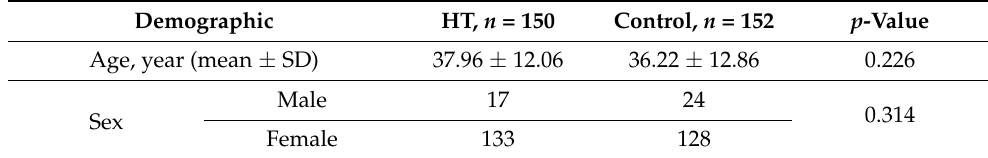
Table 1. Demographic status of the study subjects.